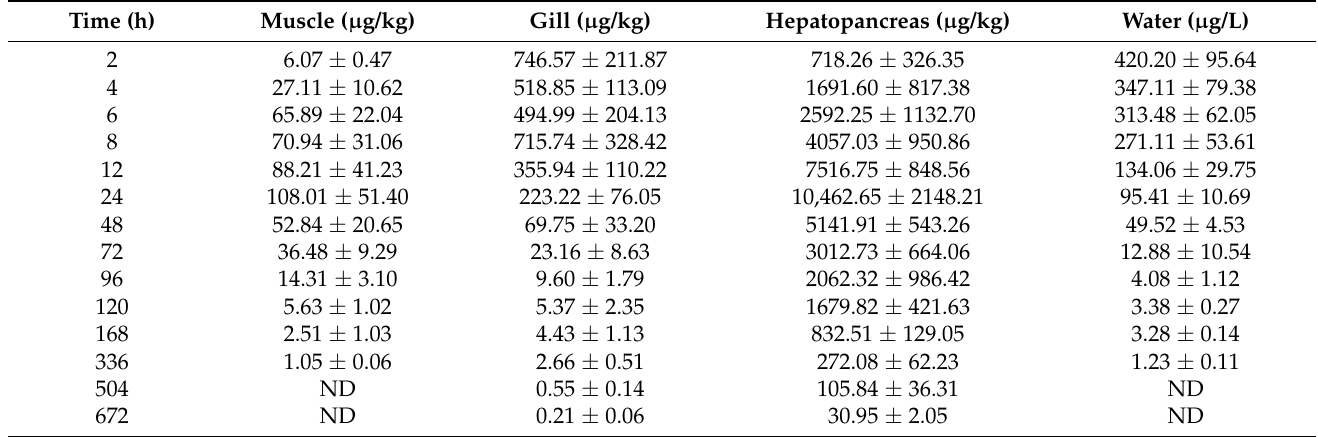
Table 4. Indoor exposure tests of pendimethalin added to tank water at 1.6 mg/L.